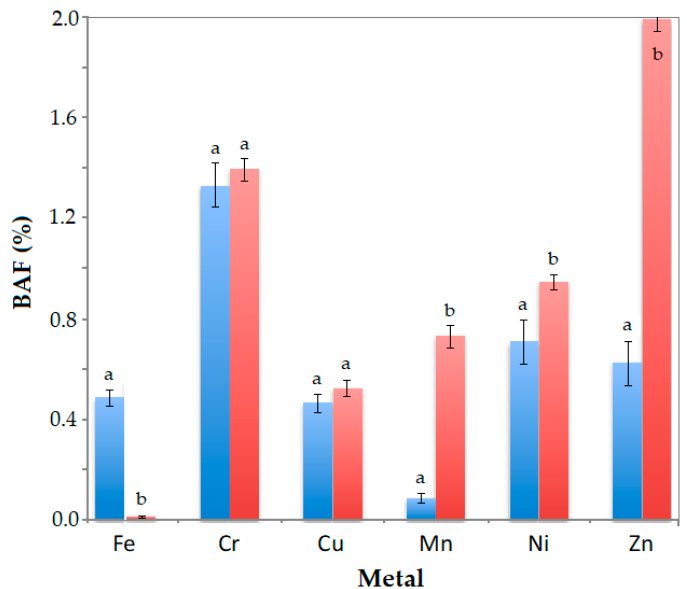
Figure 7. Bioaccumulation factors in roots (blue bars) and aerial parts (red bars) of J. curcas L. after 90 days planted in CS. Different letters in BAF bars of a metal indicate significant differences between BAF root and BAF aerial according to Duncan’s multiple range test ( p ≤ 0.05).